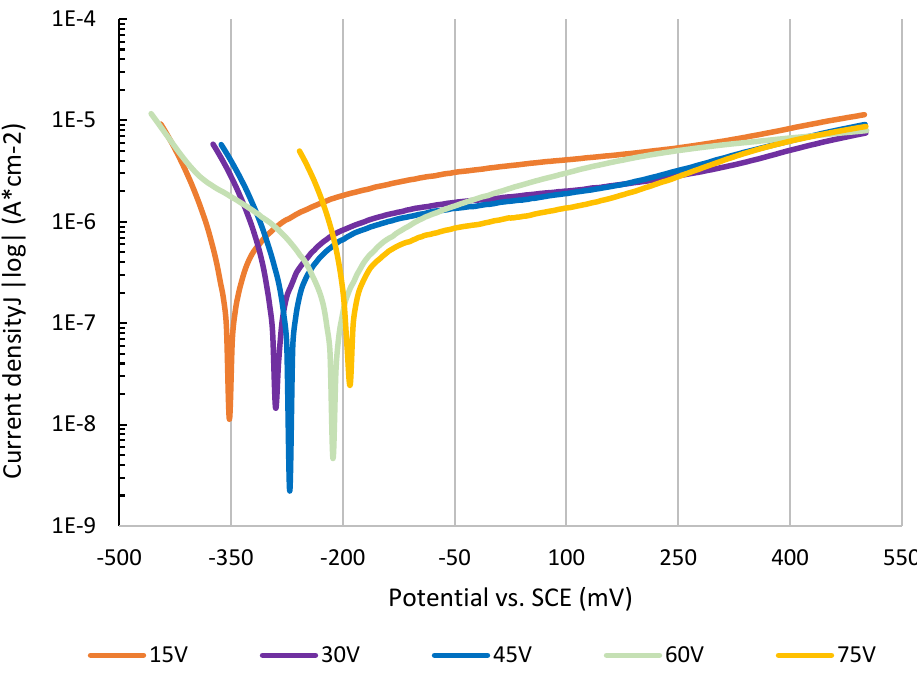
Figure 6. Polarization curves for anodized surfaces.